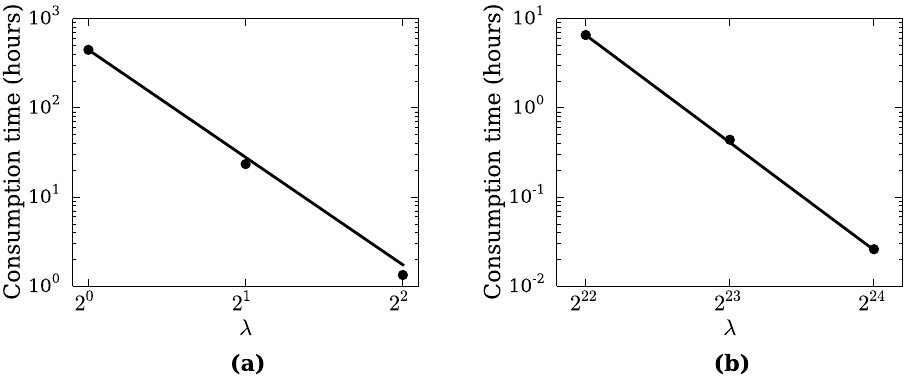
t c / 2 n ( D + 1 ) . ( a ) Melting of aluminum slab. ( b ) =